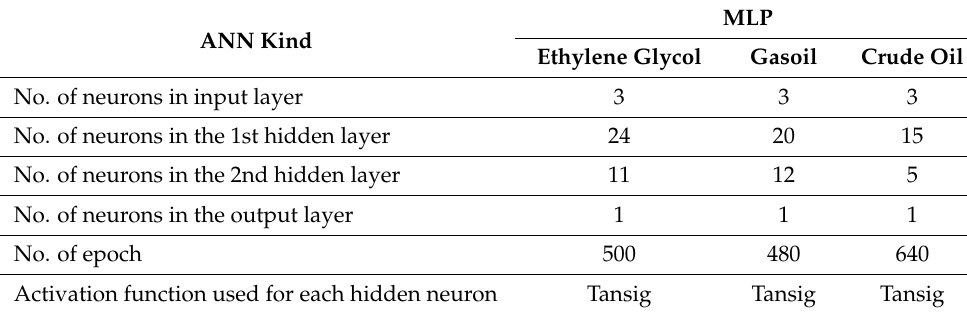
Table 1. The characteristics of designed